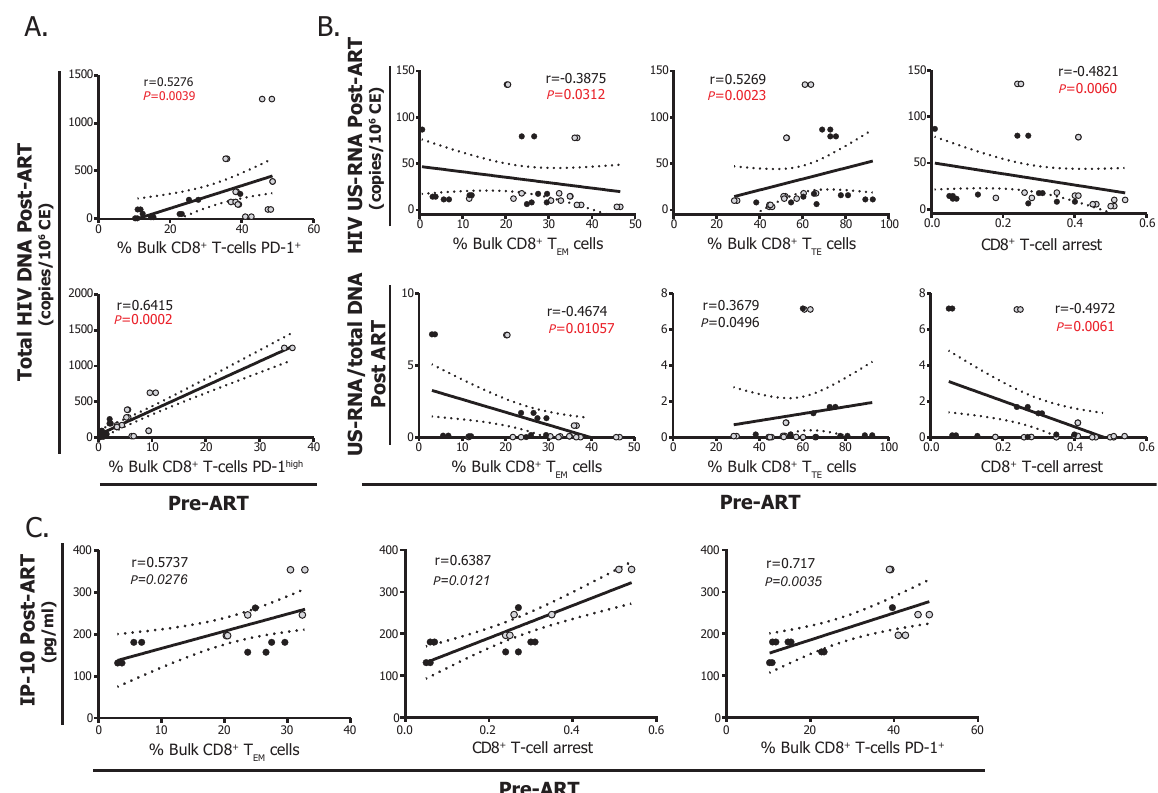
Figure 2: Correlations analysis between the phenotype of CD8+ T-cell response pre-cART and HIV persistence and inflammation post-cART. A. Correlations between the expression of PD-1 in bulk CD8+ T cells pre-cART and levels of total HIV DNA. Proportion of total PD-1+ cells (PD-1 high + PD-1 low ) are shown in the upper panel and PD-1 high cells in the lower panel. B. Correlations between the percentages of bulk CD8+ T and T cells as well as CD8+ T-cell arrest pre-cART with the levels of US-RNA EM TE (upper panels) and the US-RNA/total DNA ratio (lower panels) post-cART. C. Correlations between the percentages of bulk CD8+ T , CD8+ T-cell arrest and the proportions of PD-1 expressing CD8+ T EM cells pre-cART with post-cART IP-10 plasma levels. Black dots represent ET participants and gray dots represent DT participants. The r and P values correspond to Spearman’s test. Those correlations that remained statistically significant after correction for multiple comparisons are shown in red. In C, P values were not corrected and shown in italics. SCM: stem-cell memory, CM: central memory, EM: effector memory, TE: terminal